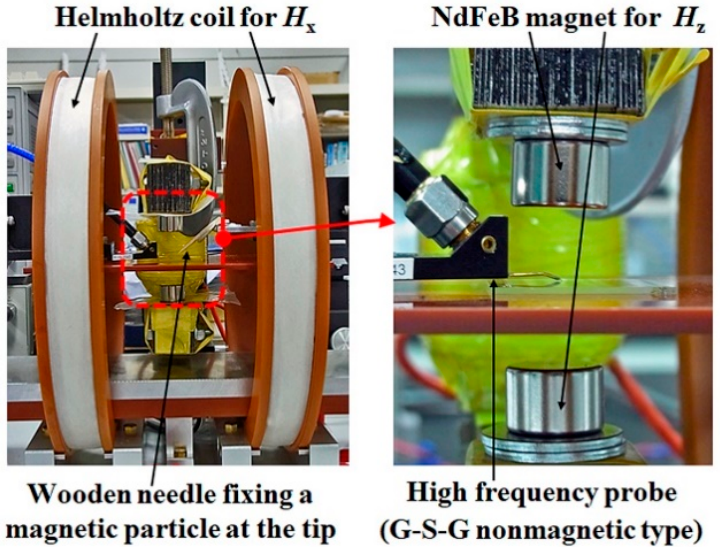
Figure 11. Photograph of measurement apparatus.